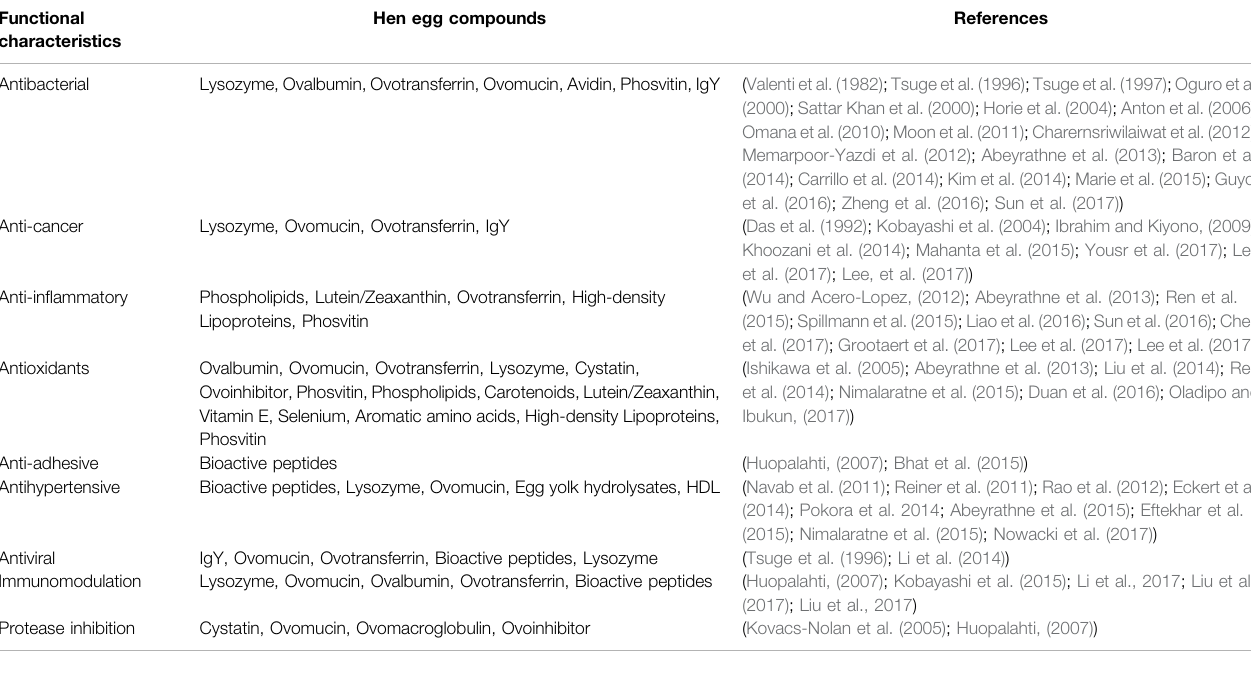
TABLE 1 | Functional property of Egg components.